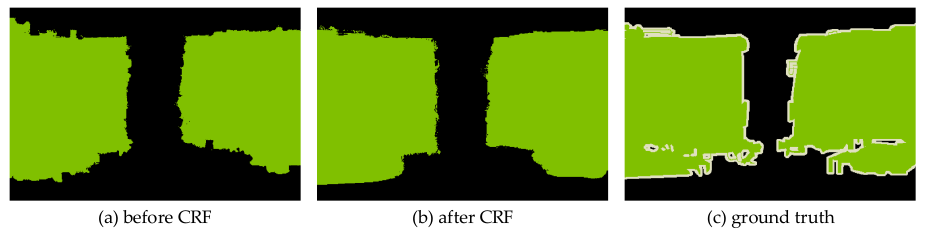
Figure 5. An example of before/after CRF.